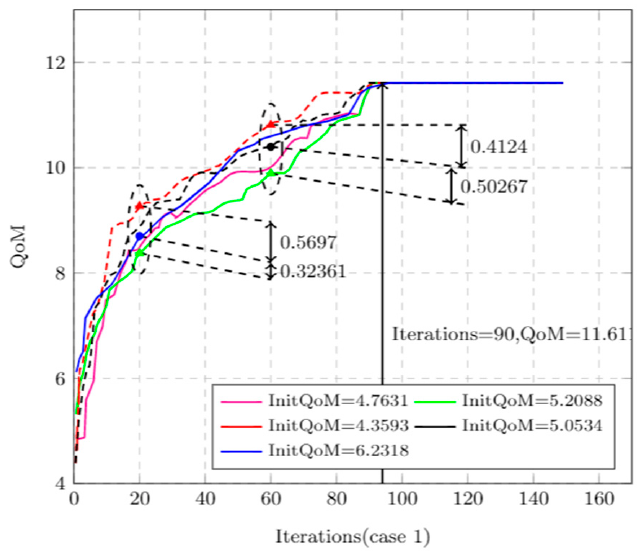
Figure 12. Convergence experiment in Case 1.